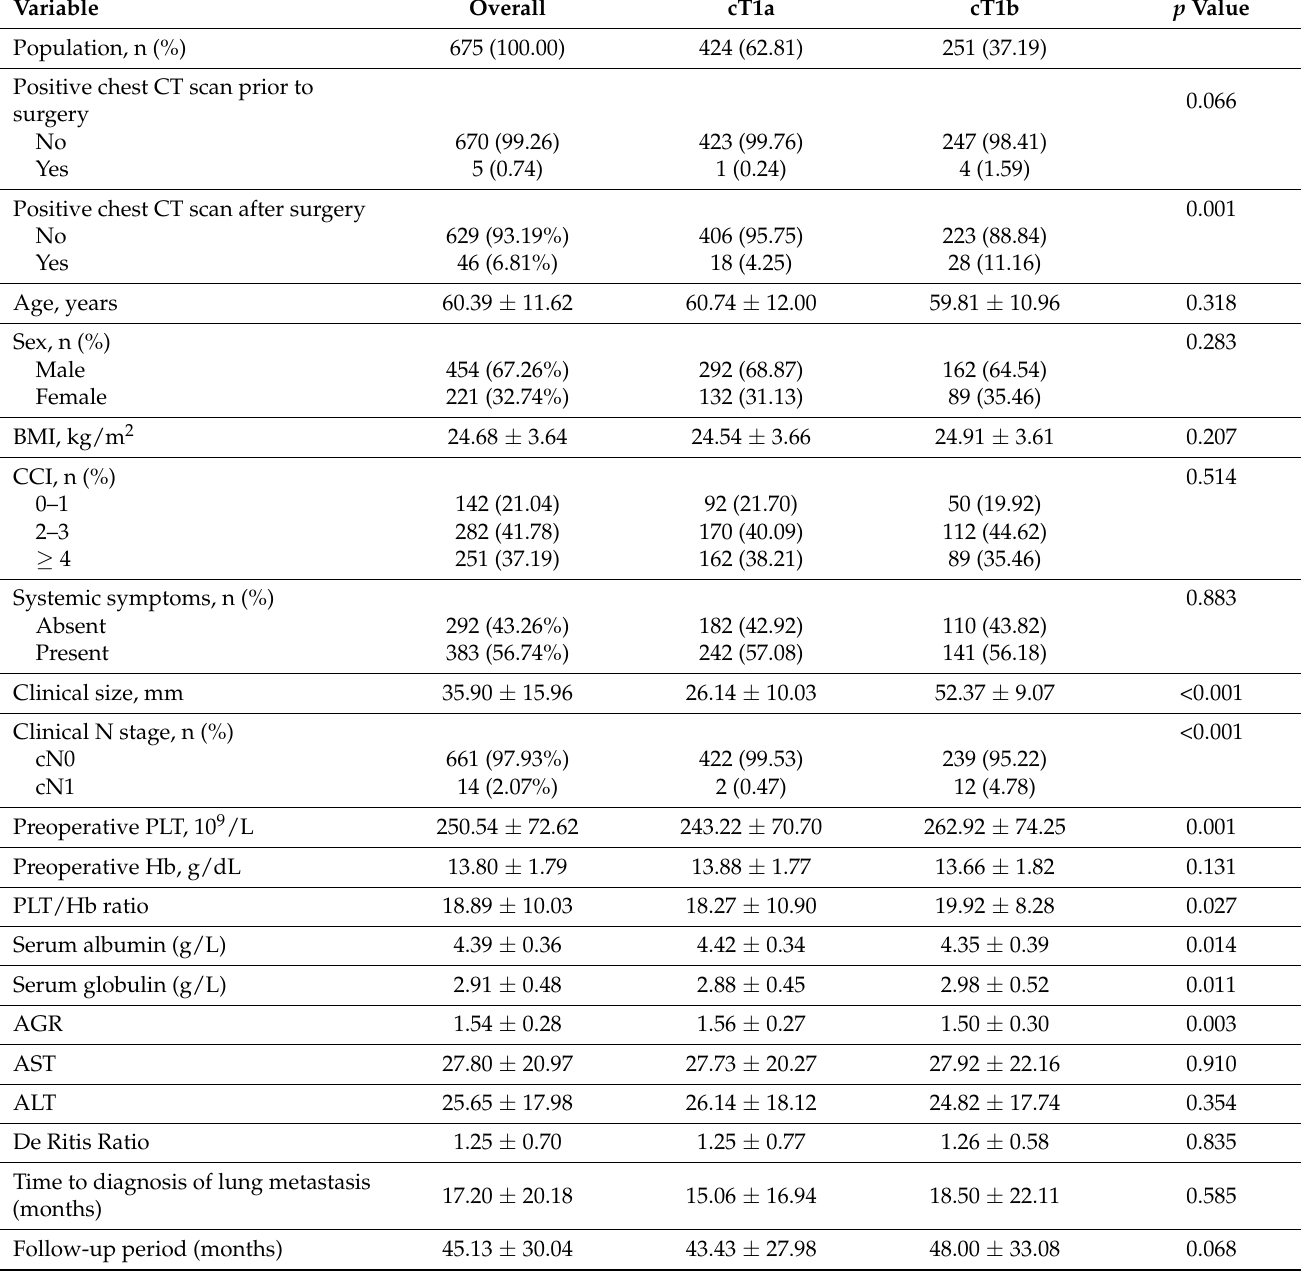
Table 2. Subgroup analysis of only patients with clinical T stages cT1a and